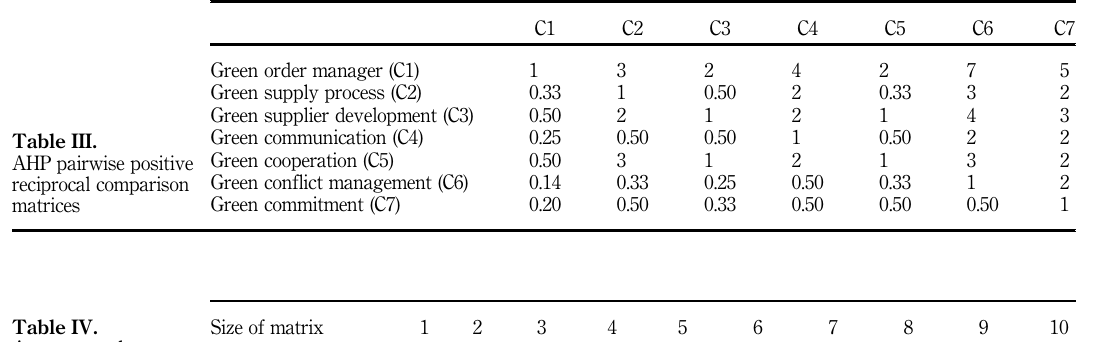
Table IV. Average random consistency